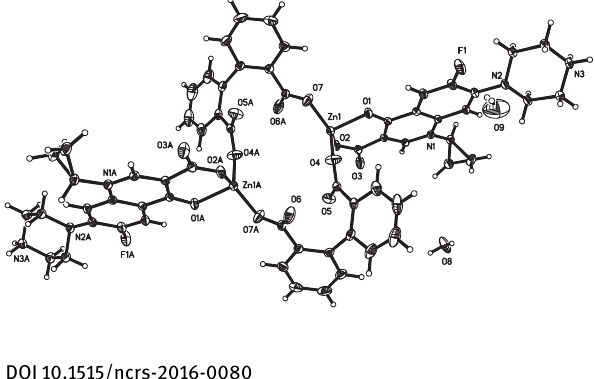
Table 1: Data collection and handling.